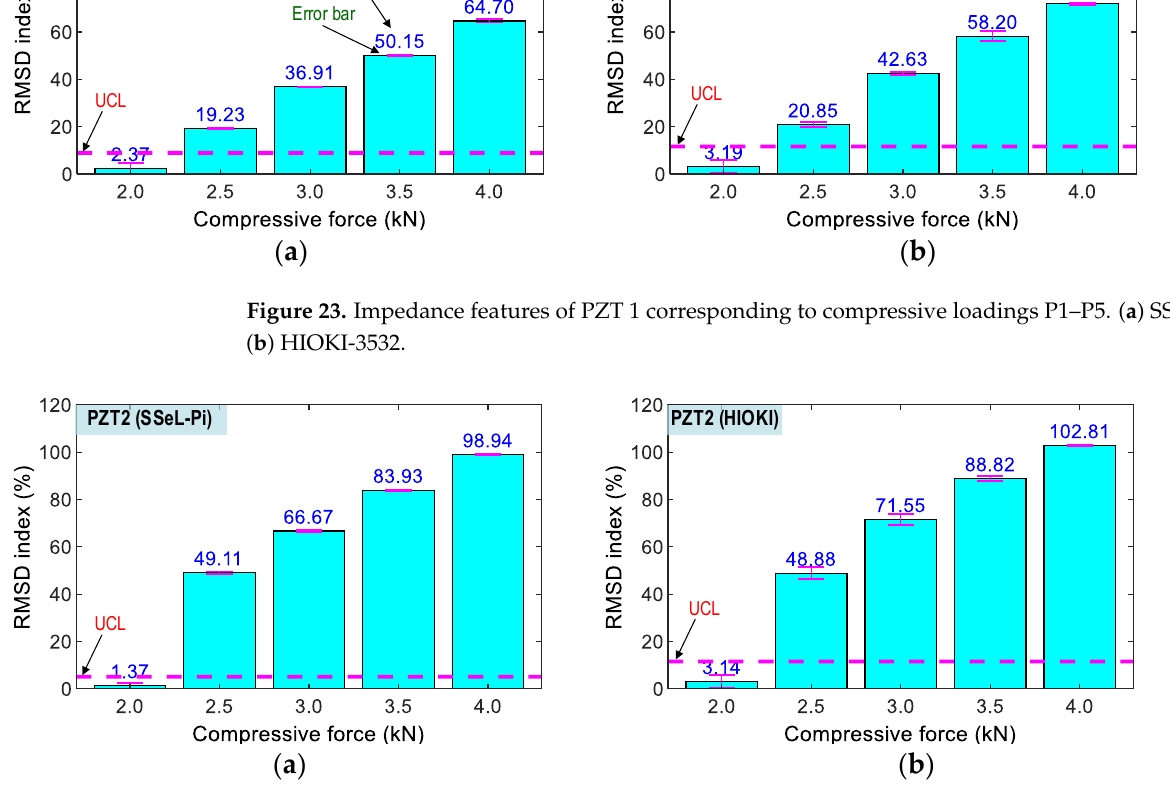
Figure 24. Impedance features of PZT 2 corresponding to compressive loadings P1 – P5. ( a ) SSeL-Pi, ( b ) HIOKI-3532.